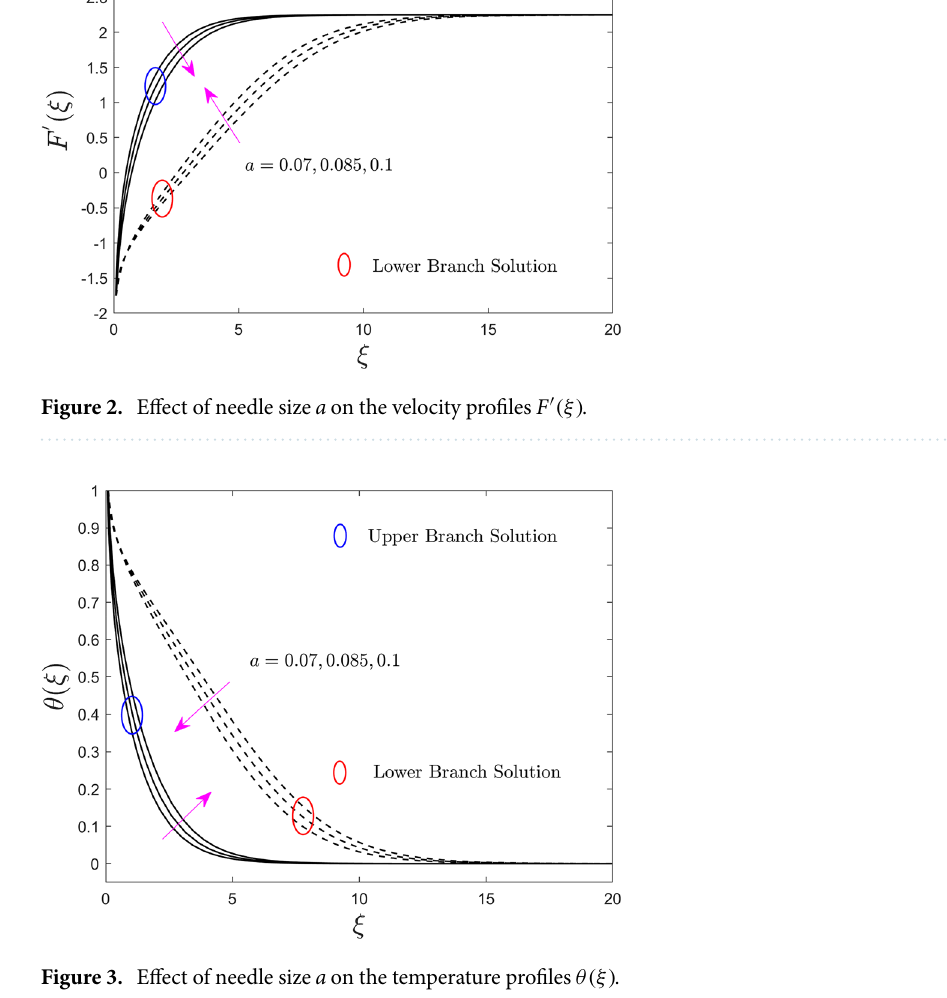
Figure 3. Effect of needle size a on the temperature profiles θ(ξ)